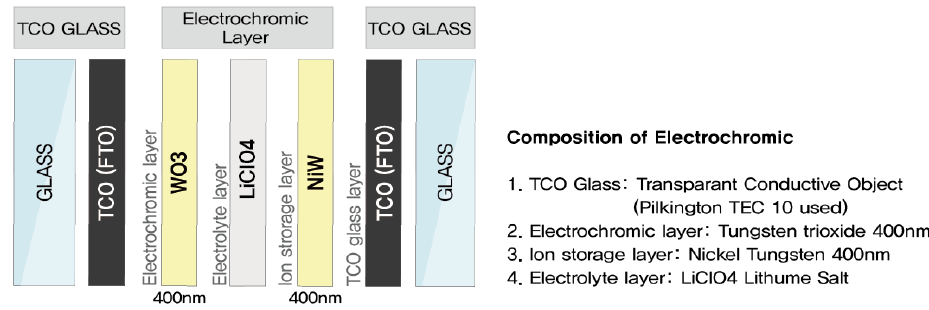
Figure 2. Composition of electrochromic glass.